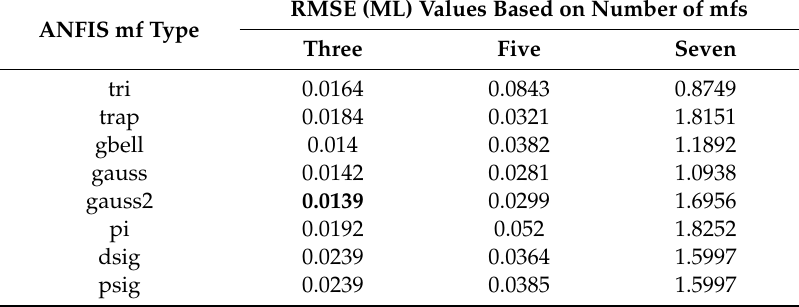
Table 2. Comparison of water demand errors for several kinds and numbers of ANFIS membership